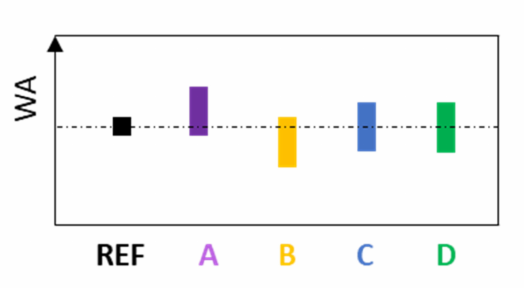
Figure 21. Predicted water absorption of CC depending on the type of mineral